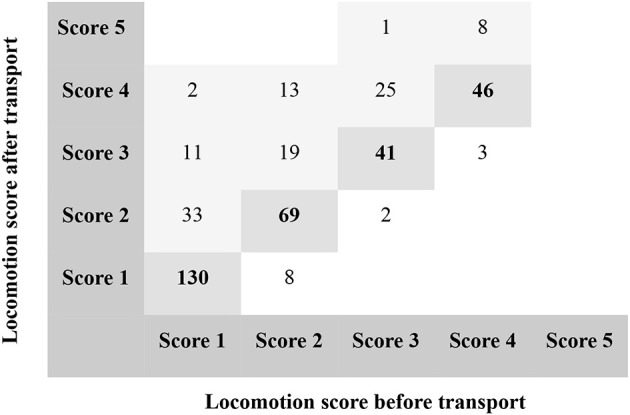
Number of cull dairy cows with a given locomotion score before (x-axis) and after transport (y-axis) to slaughter, N = 411. The diagonal line of numbers in bold represents cows that scored the same before and after transport. Numbers above the diagonal represent cows that scored higher after transport; numbers below the diagonal represent cows that scored lower after transport.